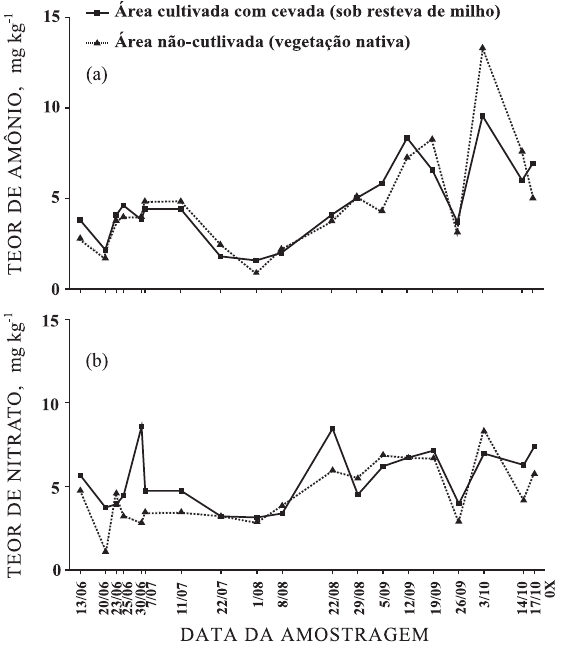
Figura 5. Teores de amônio (a) e nitrato (b) do solo em amostras retiradas da área cultivada com cevada (sob resteva de milho) e da área não- cultivada (vegetação nativa) no período entre 13/06/2002 e 17/10/2002, Eldorado do